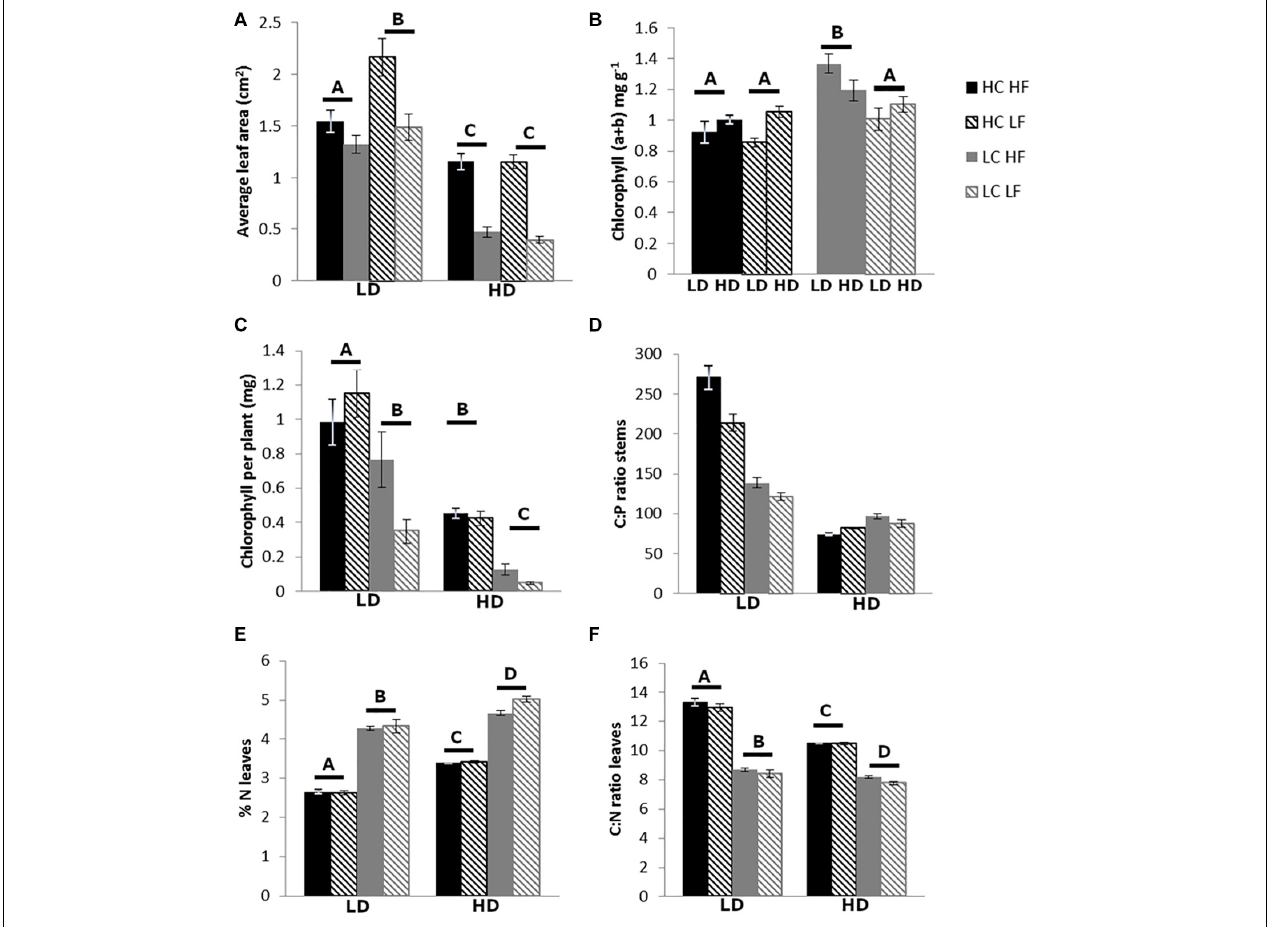
FIGURE 4 | Average leaf area (A) , total chlorophyll concentration (B) , total amount of chlorophyll per plant (C) , C:P ratio of the stems (D) , % N in the leaves (E) , and C:N ratio of the leaves (F) . The letters above the graph indicate significant differences ( p < 0.05, n = 5–10), tested with three-way ANOVA. In panels (A,C,E,F) , CO 2 *DOC interactions are shown, in panel (B) a CO 2 *flow interaction and in panel (D) there were no